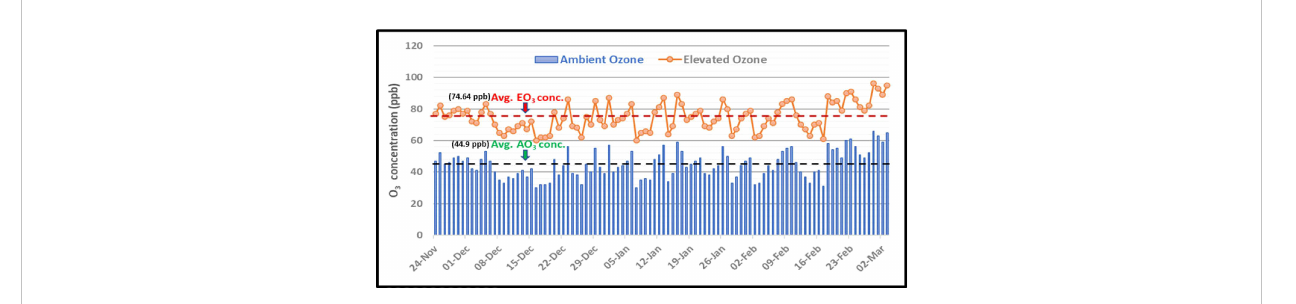
FIGURE 3 Mean 8h O 3 concentrations during the growth period of Hyacinth